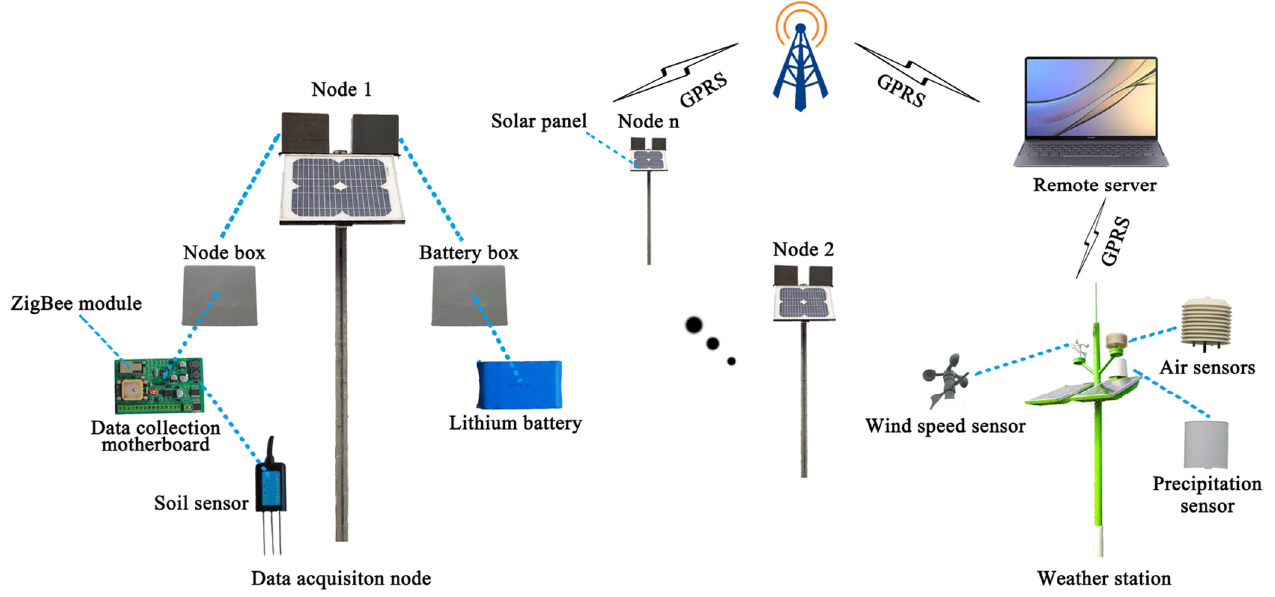
Figure 3. Hardware of citrus orchard IoT system.